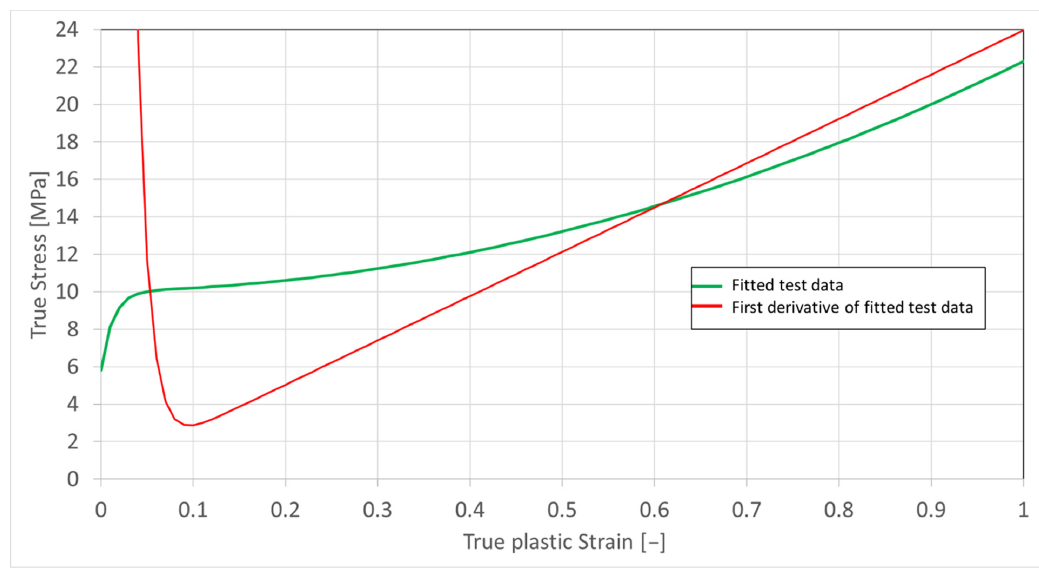
Figure 11. Extrapolated, fitted hardening curve in TD (green curve) and its 1st derivative, indicating the material stability range (red curve).